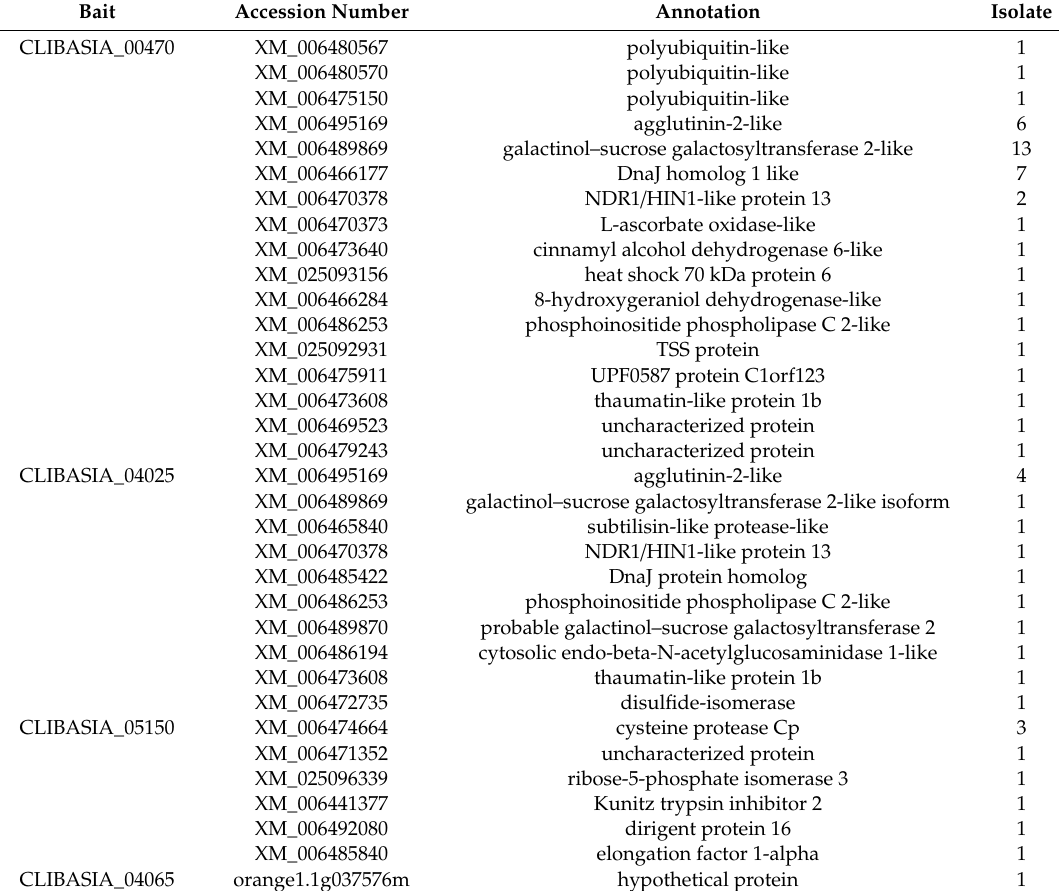
Table 2. The identified host proteins interacting with the four virulence factors by yeast